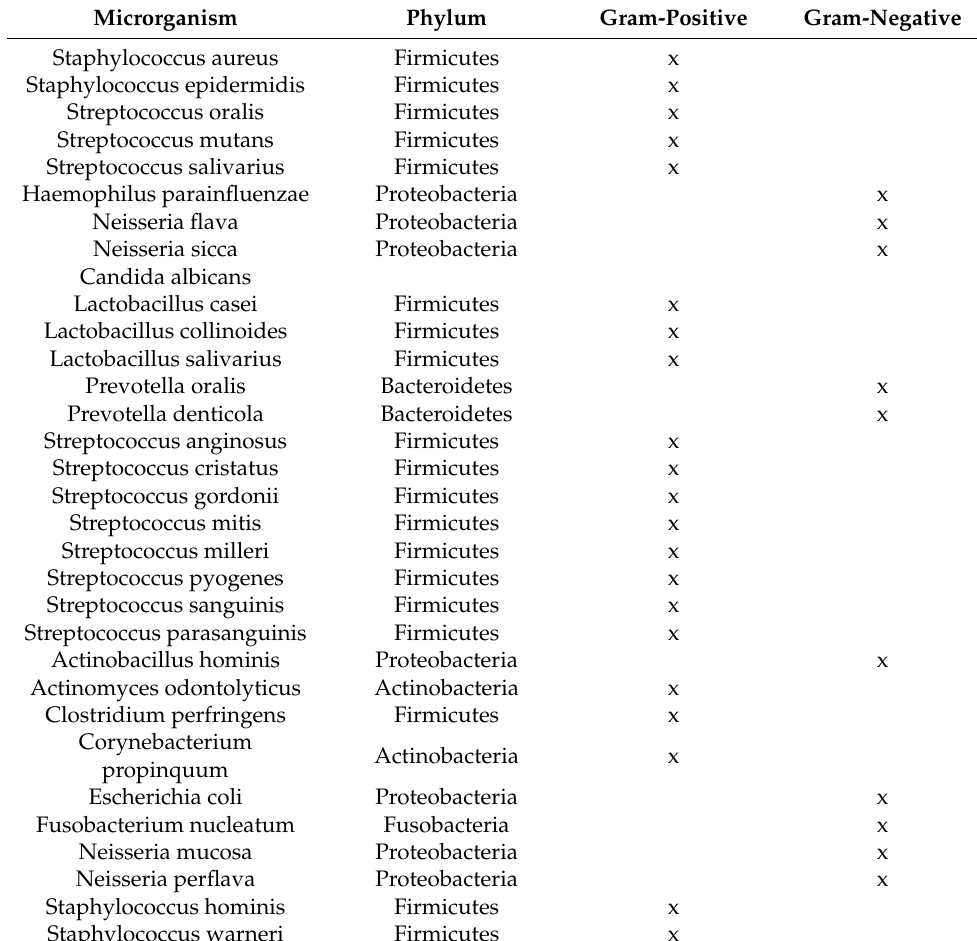
Table 1. Most represented microbial species and their phyla, divided into gram-positive and gram-